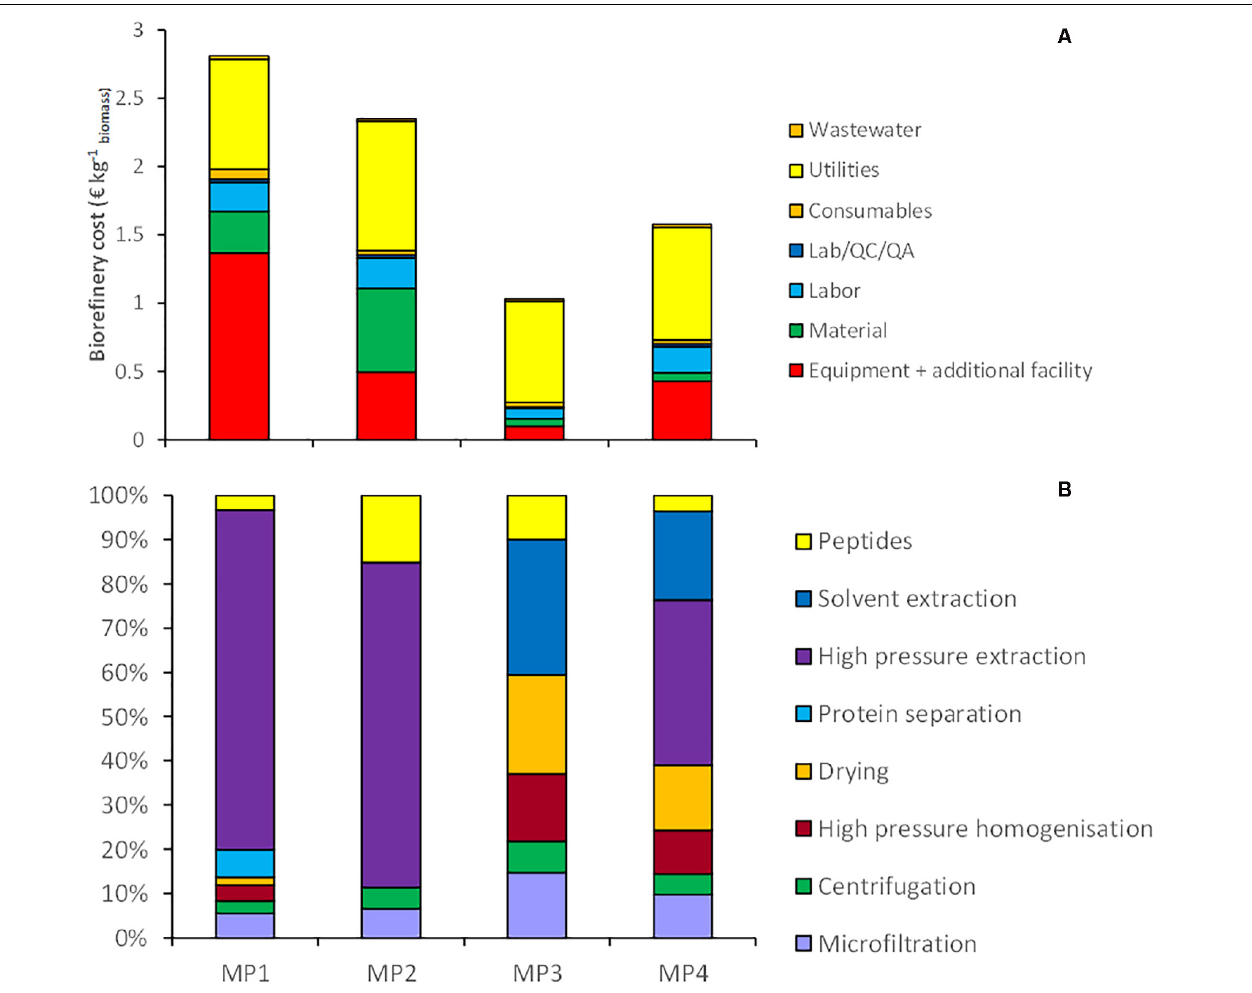
FIGURE 7 | (A) Breakdown of the biorefinery costs (excluding cultivation) for the multiproduct value (MP) chains at 10 ktons y - 1 scale, expressed per unit of initial biomass, (B) contribution of each biorefinery step to total biorefinery costs. Protein separation = Centrifugation + UF/DF + UF; Peptides = alkaline extraction + enzymatic